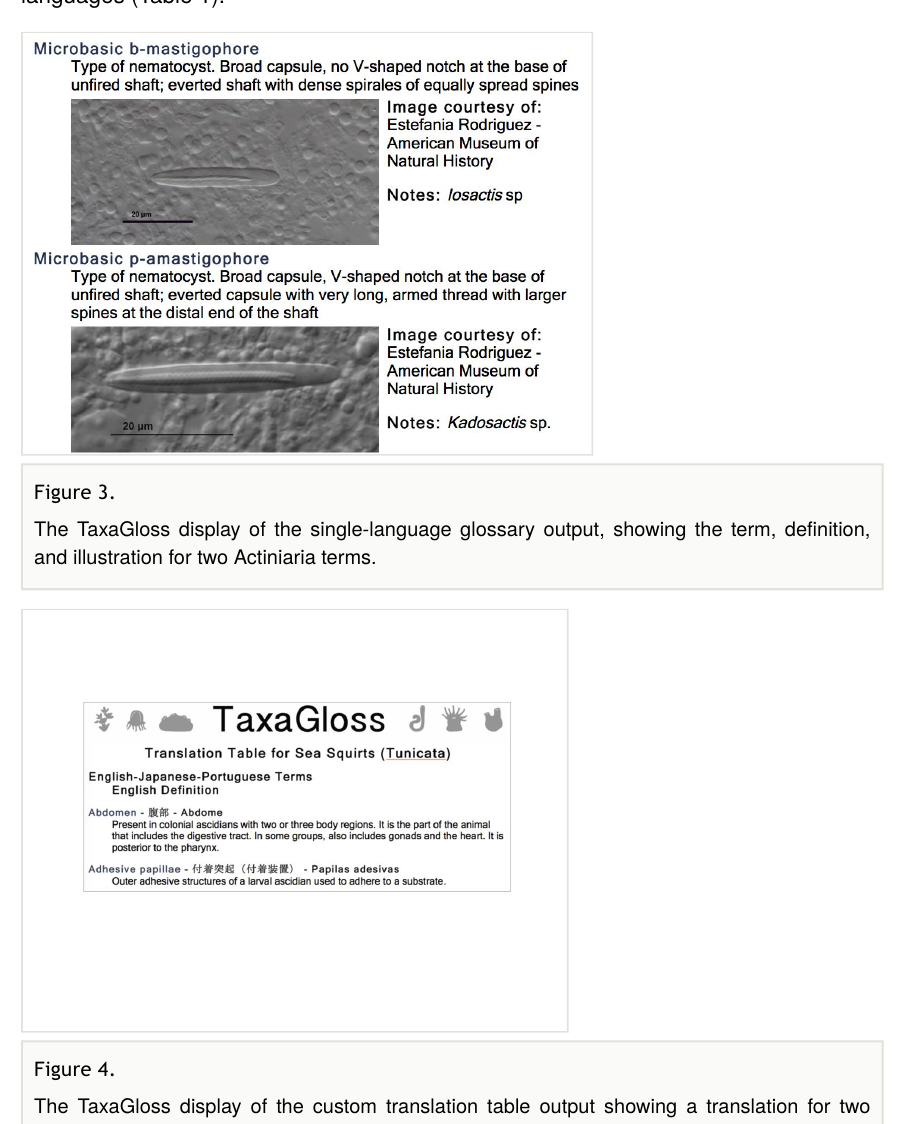
The TaxaGloss display of the custom translation table output showing a translation for two Tunicata terms between English, Japanese and Portuguese with a de fi nition in